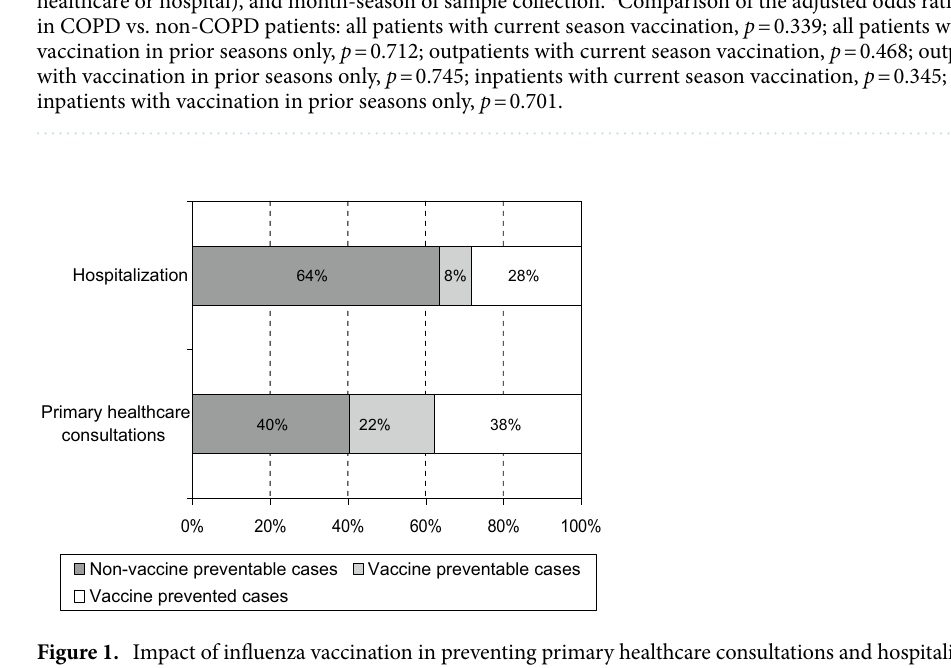
vaccination in the current season. Both estimates seemed higher in preventing outpatient cases (60% and 58%, respectively) than hospitalized cases (37% and 19%, respectively), with no statistically significant differences between settings. Recent studies evaluated influenza vaccine effectiveness in preventing influenza hospitaliza- tions in COPD patients, and reported similar results for current-season vaccination (38–48%) 14–16 . However, none of these studies had considered prior vaccination history or the effect in preventing primary healthcare consultations.